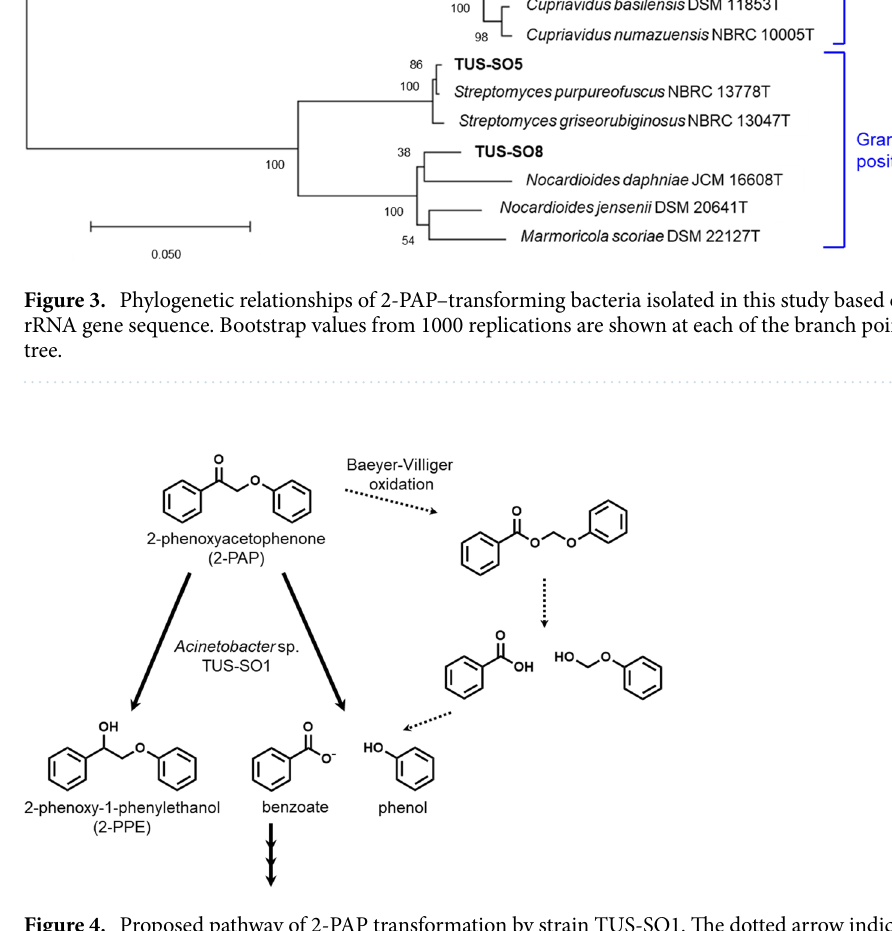
Figure 4. Proposed pathway of 2-PAP transformation by strain TUS-SO1. The dotted arrow indicates the reported chemical transformation pathway via Baeyer–Villiger